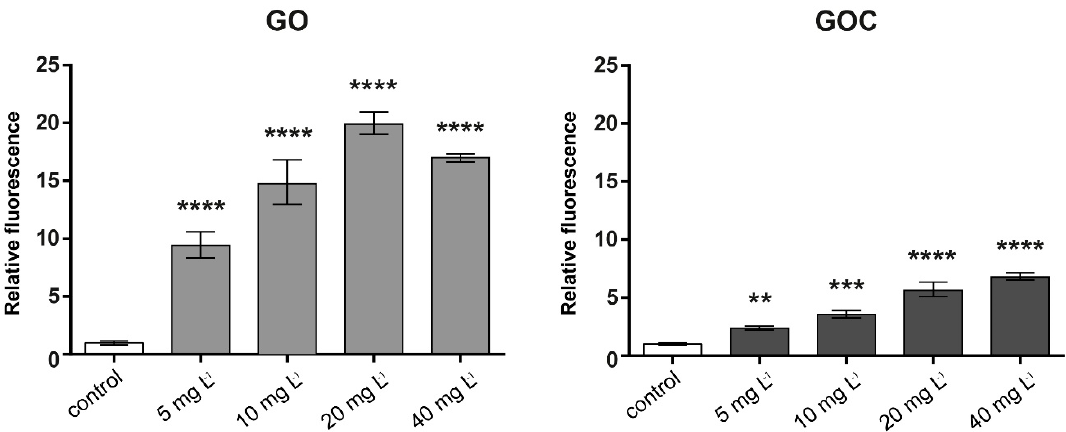
Figure 5. Reactive oxygen species (ROS) production of A549 cells treated with different concentrations of GO ( left ) and GOC ( right ). The reported values are expressed in arbitrary units and correspond to the averages of two biological replicates per culture condition. Data represent the mean of three replicates (±standard deviation, SD). Differences were established using a one-way ANOVA followed by Dunnett post hoc test to compare every mean with the control, and considered significant at p ≤ 0.05. ** p ≤ 0.01, *** p ≤ 0.001, **** p ≤